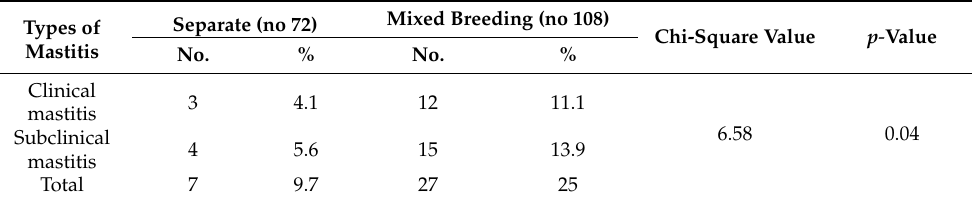
Table 2. Occurrence of E. coli in mastitic she-camel’s milk in relation to camel breeding system (mixed with other species).